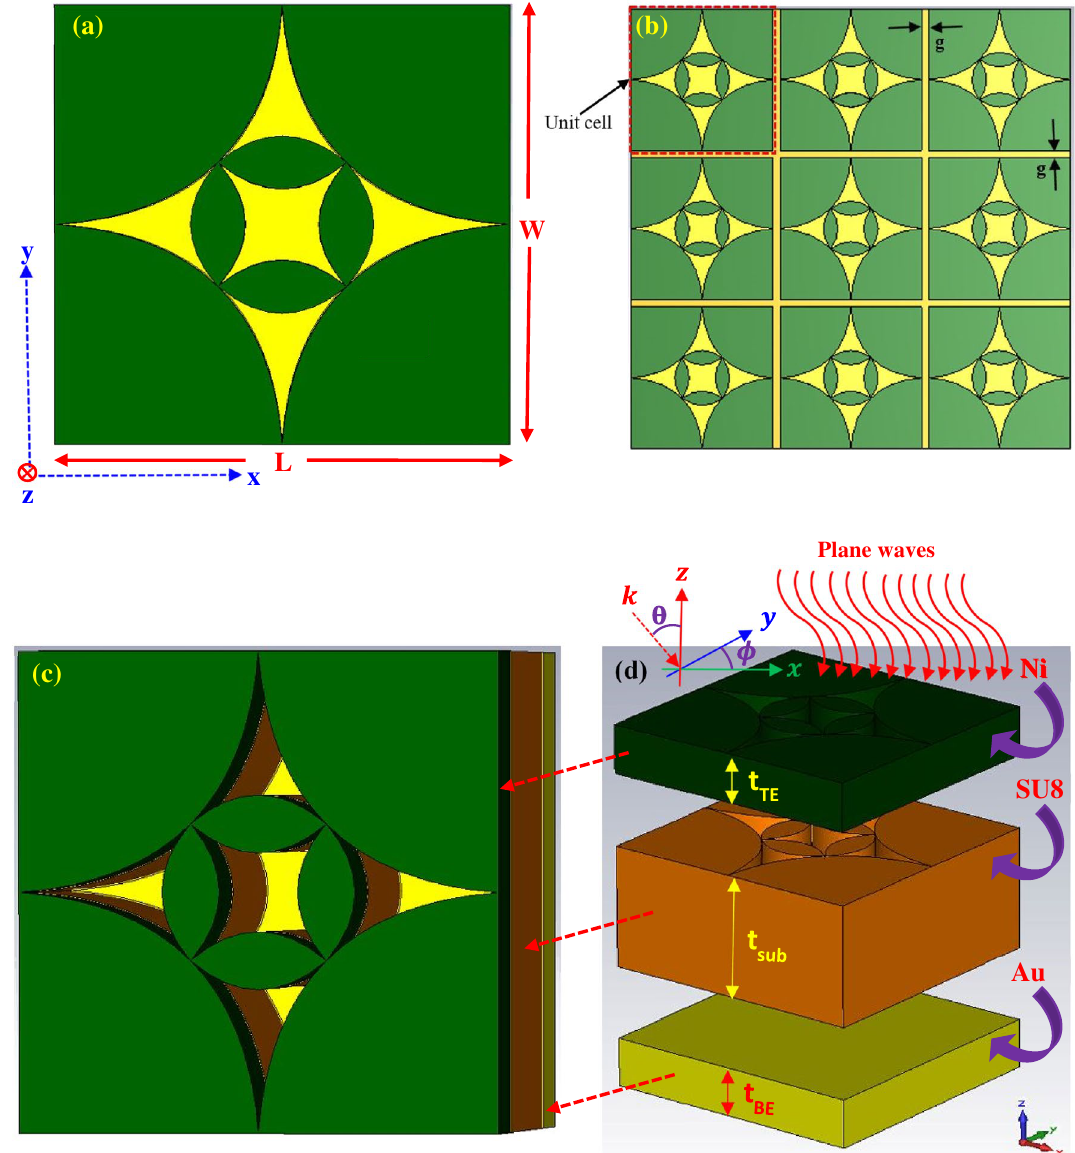
Figure 1. Schematic of the designed broadband antenna: ( a ) front view of the unit-cell structure and ( b ) 2-D periodic array (3 × 3 unit cells) structure in x–y plane. The unit-cell is composed of metallic (Ni) and dielectric (SU8) flower petals over the ground gold (Au) plate, ( c ) perspective view of the unit-cell (the top metal (Ni) and substrate (SU8) are patterned and shaped in a groove like structure), ( d ) 3D demonstration of the structure with a unit cell, in which each layer is separated from each other for clear